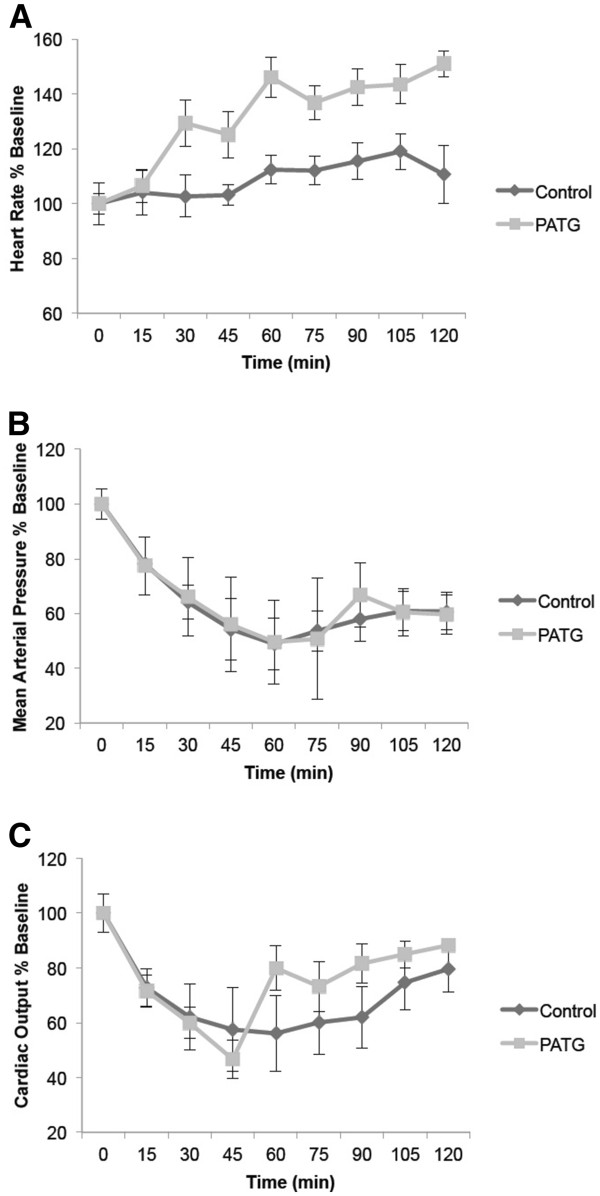
Hemodynamic profiles during hemorrhage period for experimental and control groups. A) Heart rate. B) Mean arterial pressure. C) Cardiac output.